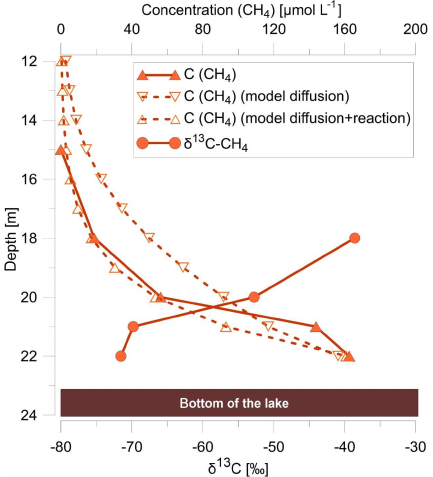
Figure 4. Depth profiles of methane concentration (filled triangles) and its isotopic composition (filled circles) within the water col- umn, modeled methane concentrations (open triangles) using a 1-D diffusion model with a turbulent diffusion coefficient for K z CH4 of 0.1m 2 d − 1 (model diffusion), and a 1-D diffusion model ad- ditionally linked with a degradation term (first-order rate constant k = 0 . 03d − 1 ) (model diffusion and